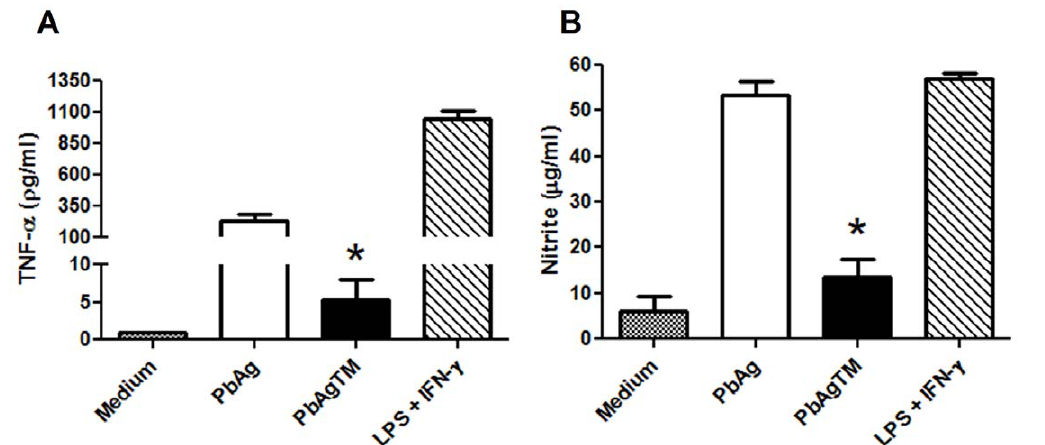
Figure 6. Effect of underglycosylation on the yeast proteins ability to induce inflammatory mediator production in macrophages. Adherent cells from the peritoneal cavities of C57BL/6 mice were stimulated in vitro for 48 h with crude extracts of P. brasiliensis yeasts with (PbAgTM) or without (PbAg) TM treatment. Stimulation with LPS + IFN- c was used as a positive control. The culture supernatants were assayed for TNF- a (A) and NO (B) levels. Data are representative of 3 independent assays. * p , 0.05 between PbAgTM and